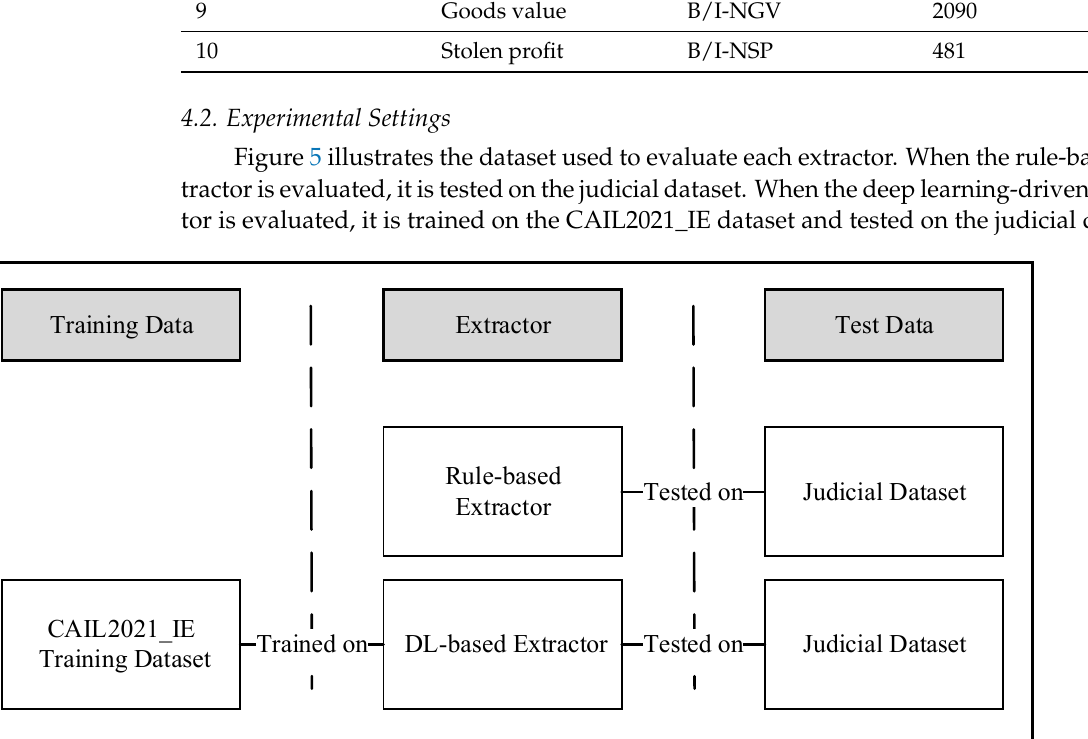
Figure 5. Setting of experimental datasets.